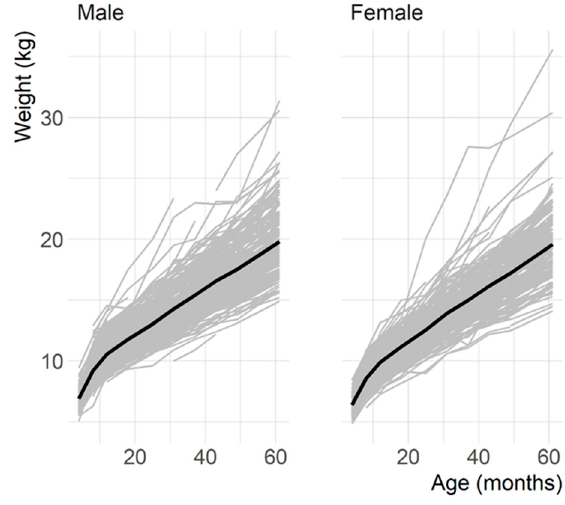
Figure 2. Weight trajectories from measurements of 544 children taken between 4 and 61 months of age, and mean weight highlighted in black.